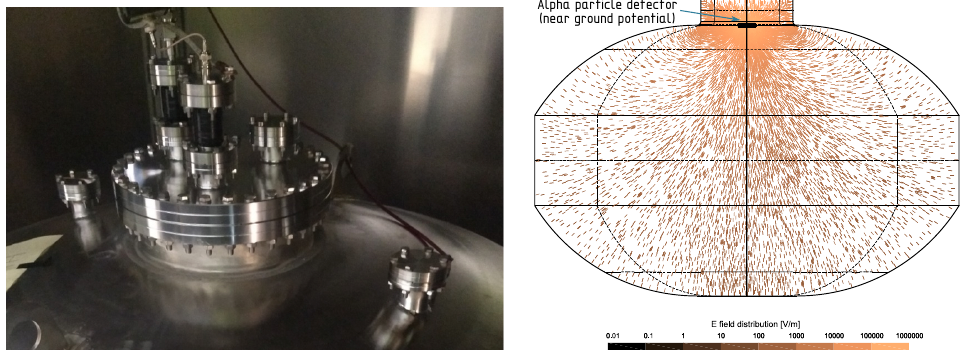
Figure 5. Left : Picture of the ERM. Right : Simulation of the electric field lines inside the ERM